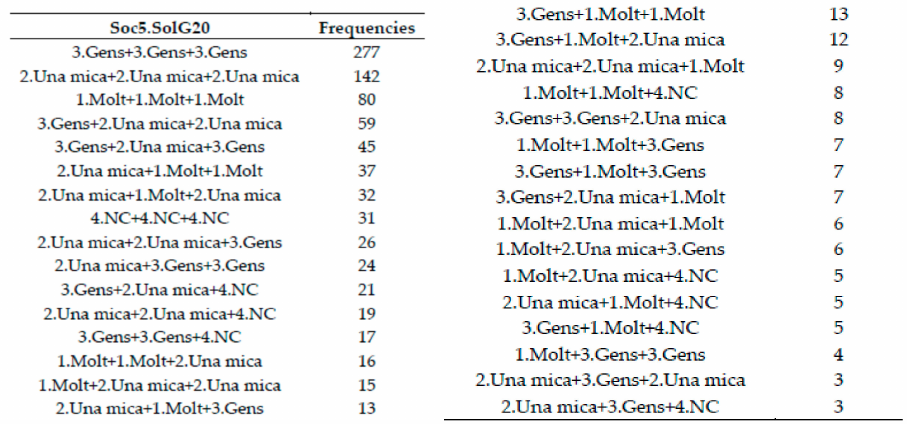
Figure 40. Trajectories Frequency table of trajectories with frequency greater than 3.